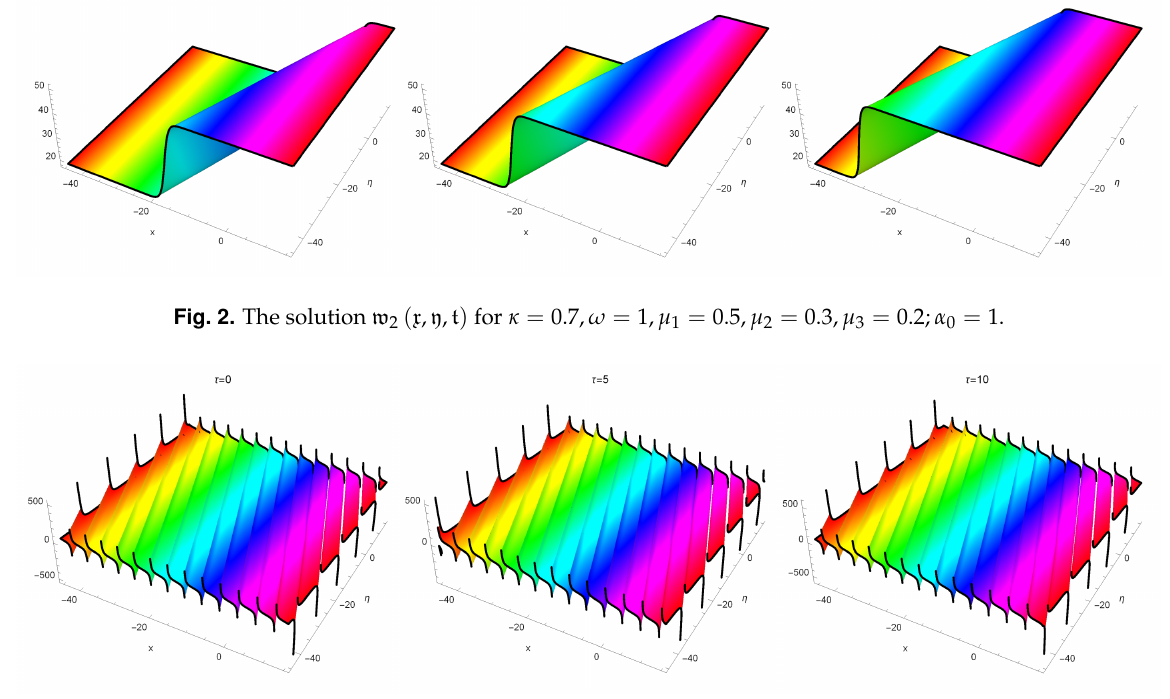
Fig. 3. The solution w 3 ( x , y , t ) for κ = 0.7, ω = 1, µ 1 = 0.5, µ 2 = 0.3, µ 3 = 0.2; α 0 =